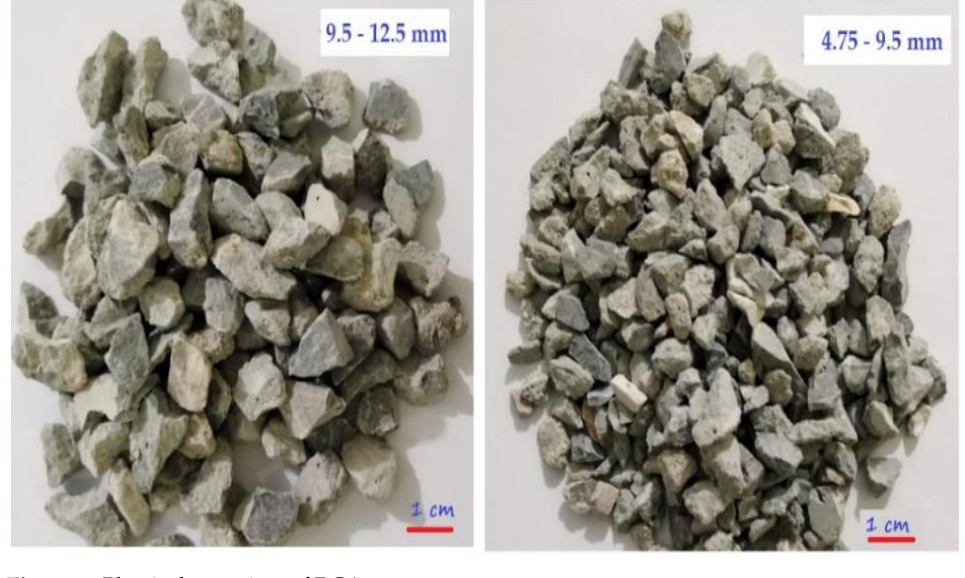
Figure 2. Physical overview of RCA.